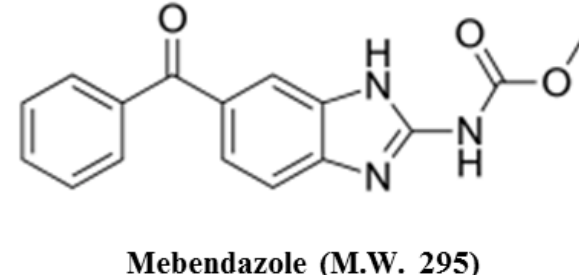
Figure 8. Structure of mebendazole.